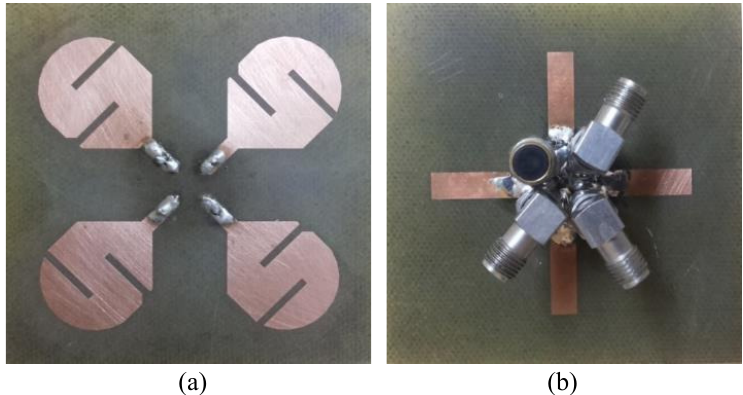
Figure 6. Fabricated prototype of the MIMO antenna system: ( a ) top side; ( b ) bottom side.